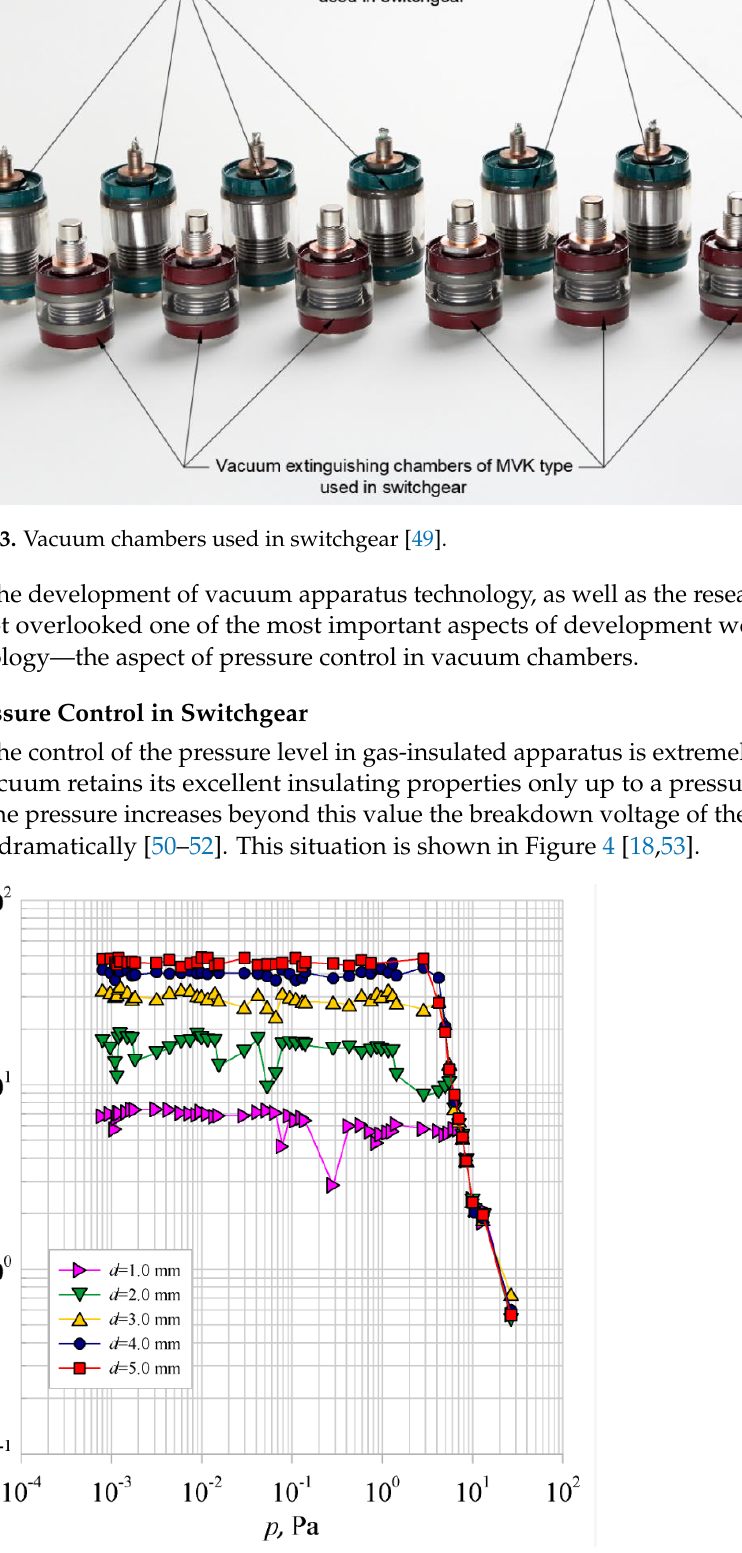
Figure 2. Cross-section of an example vacuum chamber: 1 — place of connection to the movable contact, 2 — spring bellows, 3 — moving pole, 4 — ceramic part of the housing, 5 — WCu contact, 6 — condensation screen, 7 — glass part of housing, 8 — stationary pole, 9 — place of connection to stationary contact.